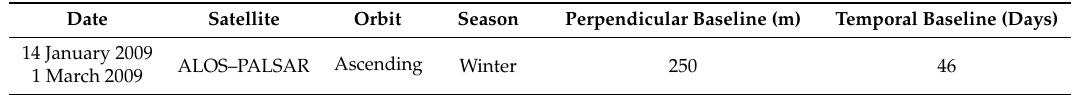
Table 1. Characteristics of the SAR imagery used for the ice motion estimation.